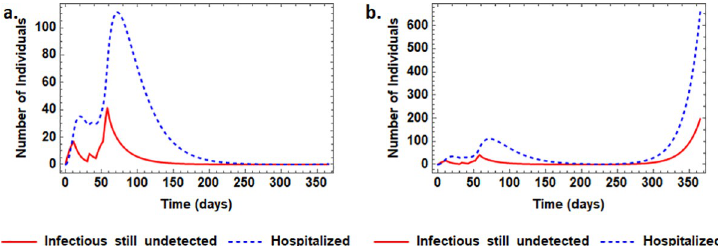
Fig 4. The possibility of having a second wave of COVID-19 infections upon easing lockdown measures with no hospital acquired infections and after 58 days, there is assumed to be an initial 30% ease in the lockdowns and no more imported cases. Panel (a) shows easing of lockdown from 10% to 30% susceptible after 58 days and further easing to 75% after 300 days of lockdown and could be sooner if contact tracing efforts were intensified. Panel (b) is a case of easing lockdown from 10% to 30% after 58 days followed by 75% susceptible after 210 days of lockdown–a case of too many and too soon. In each scenario, all other parameter values are maintained at their default